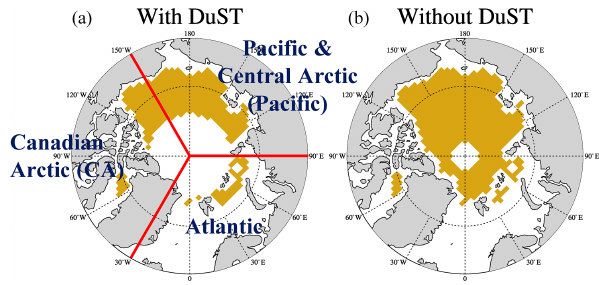
Figure 1. The common regions (yellow) of snow product inter- comparison with (a) and without (b) DuST. Also shown are the re- gions of interest in this study: Canadian Arctic (CA), North Atlantic sector (Atlantic), and Pacific and Central Arctic